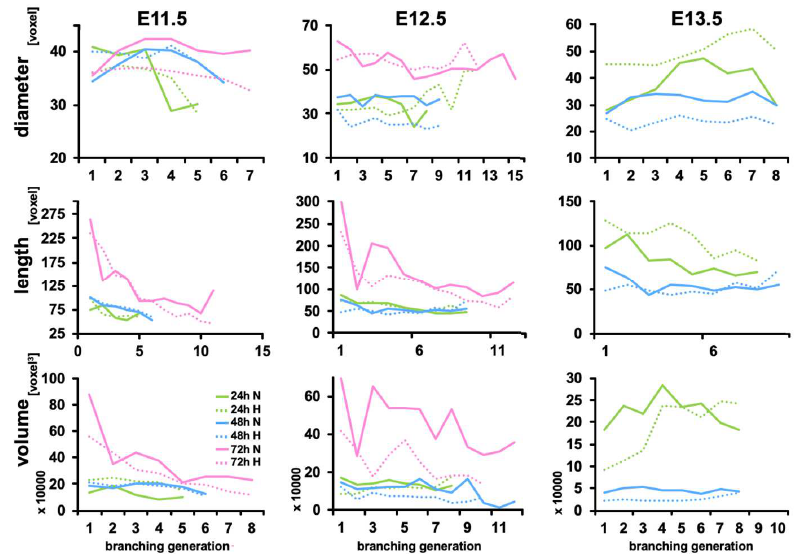
Figure 3. Diameter, length, and volume of ureteric bud branches . Analysis and comparison of ure- teric bud branch diameter, length, and volume of kidneys E11.5, E12.5, and E13.5 after 24 h, 48 h, and 72 h of in vitro culture in normal or hypoxic conditions.